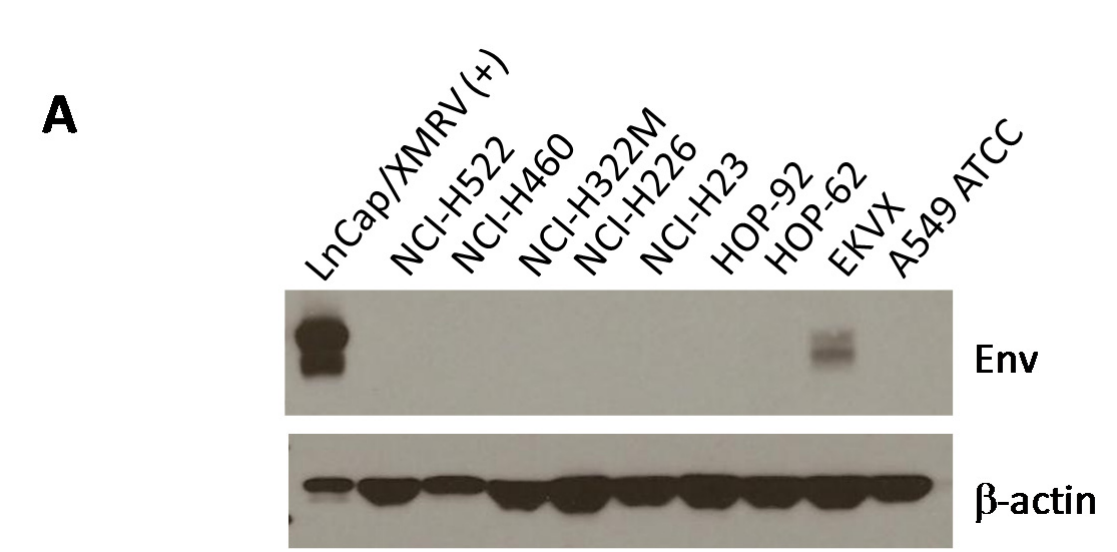
Figure 1. Detection of viral protein and DNA in the human lung adenocarcinoma cell line EKVX. Immunoblotting and PCR were carried out on all 60 cell lines of the panel; a subset are shown. Immunoblotting of total protein lysates from lung cancer cell lines for Env with monoclonal antibody 7C10 (A) . XMRV-infected LNCaP cell lysate [LNCaP/XMRV(+)] is included as a positive control. Env is present as both a precursor form (upper band) and a processed surface unit (lower band). Immunoblotting with  -actin antibody was used to confirm equal loading. Single-round PCR of genomic DNA for env (B) and gag (C) sequences. Template is genomic DNA from cell lines of the NCI-60 panel. Arrowheads indicate the expected fragment sizes: 533 bp for env and 731 bp for gag . Negative (no template) controls were run on separate gels and no products of the expected size were observed (data not shown). (D) EKVX and other representative cell lines, DU145 and HCT-116, were tested for mouse contamination by PCR for IAP using 600 ng genomic DNA as template. The positive control is genomic DNA from a mouse cell line diluted 1/10 5 in human cell line genomic